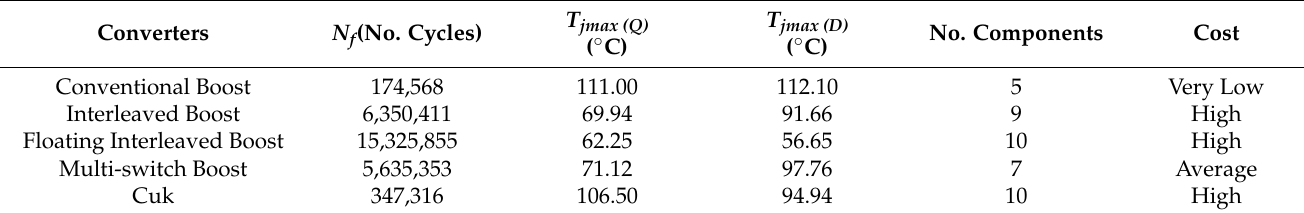
Table 2. The selected criteria and information for the ranking